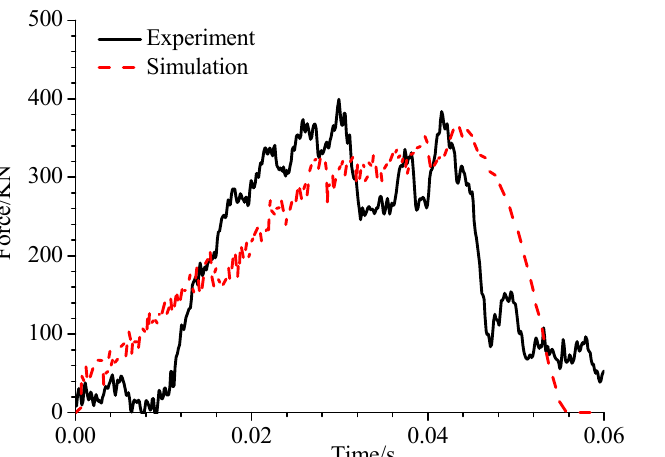
Figure 23. Comparison of the impact force distributions obtained from the experiment and simulation.